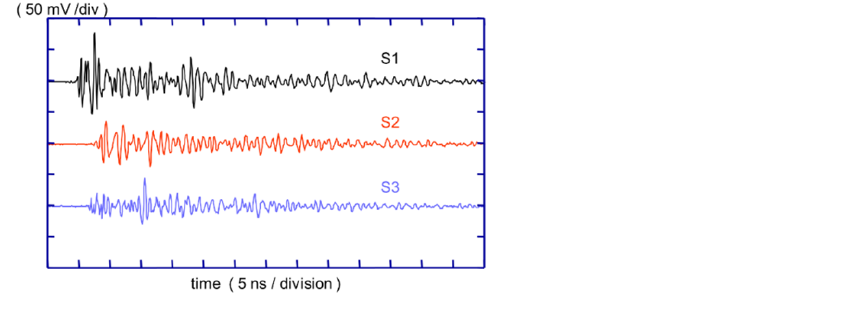
Figure 8. Time-domain signals captured simultaneously at 3 different UHF sensors S1–S3 for a single